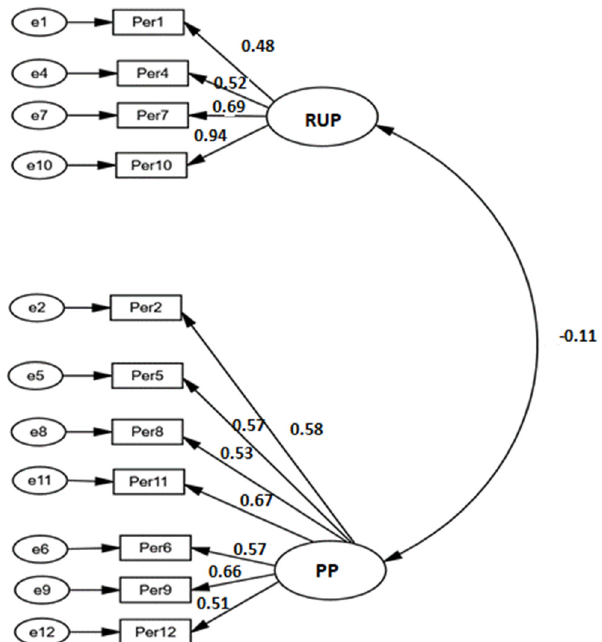
Figure 1. Structural model for the Persistence scale. Standardized weights (RUP: Recurrence of unattained purposes; PP: Purposes Pursuing).